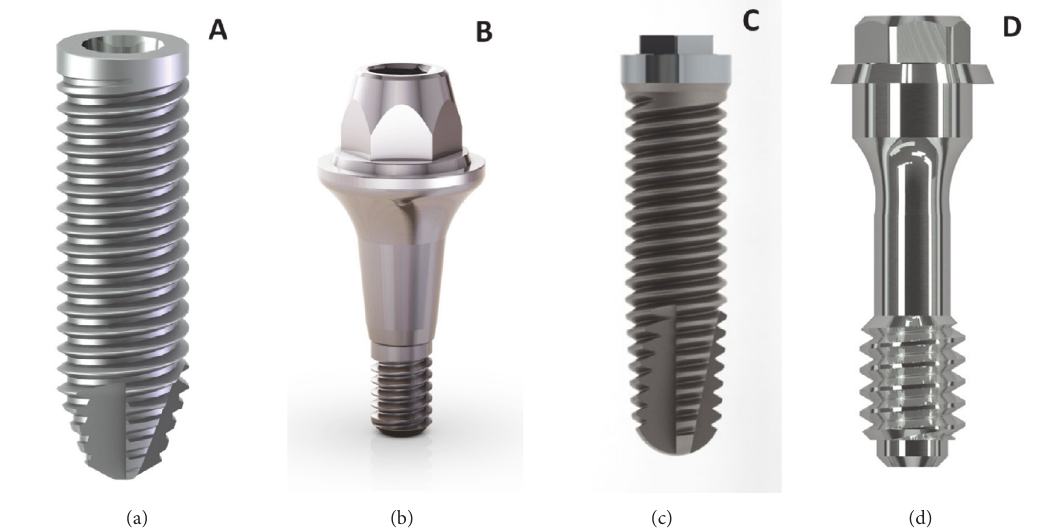
Figure 1: Implants and irrespective prosthetic abutments. Titaoss max CMX (a), universal tapered abutment (b), Titaoss external hexagon (c), and mini abutment EH platform 4.1 (d).